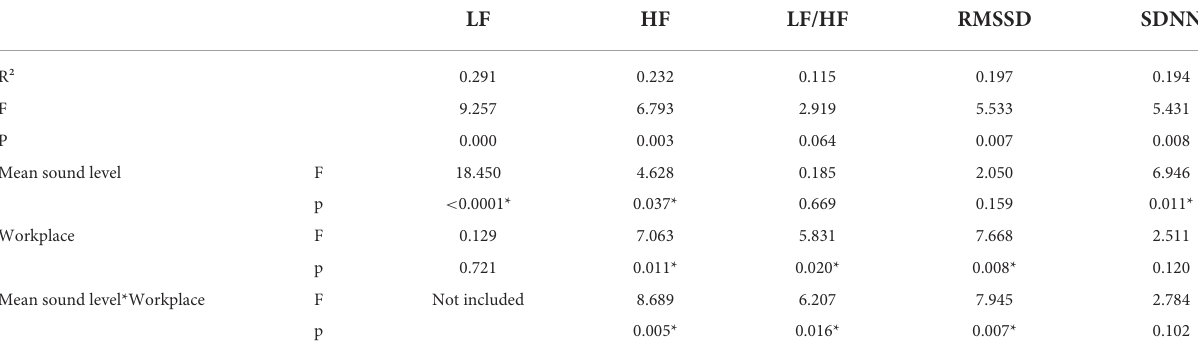
TABLE 8 ANCOVA results for mean sound level and workplace on HRV parameters.